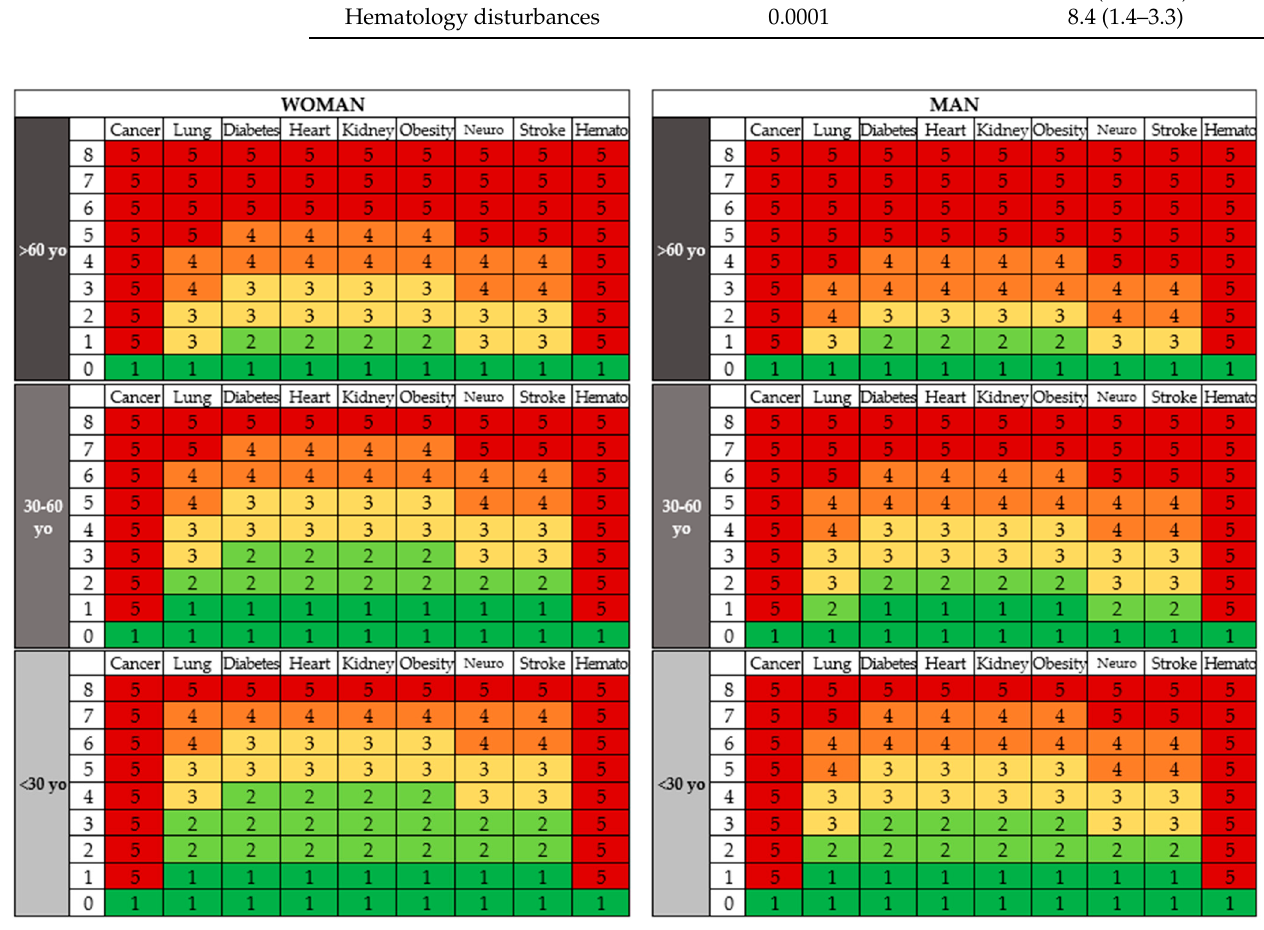
Table 4. Characteristics of the validation study. Predicted